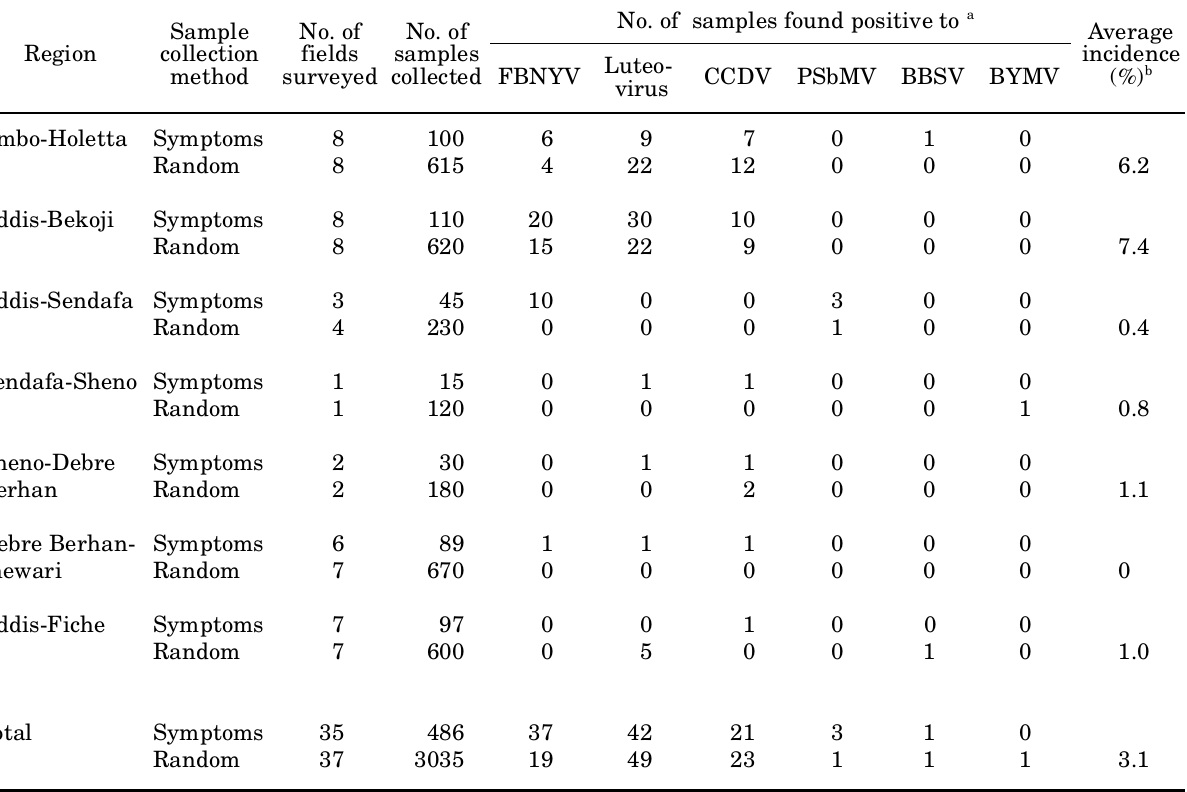
Table 3. Results of serological tests on samples collected from 37 fields in the Shewa and Arsi provinces in 1997. No. of samples found positive to a Sample No. of No. of collection